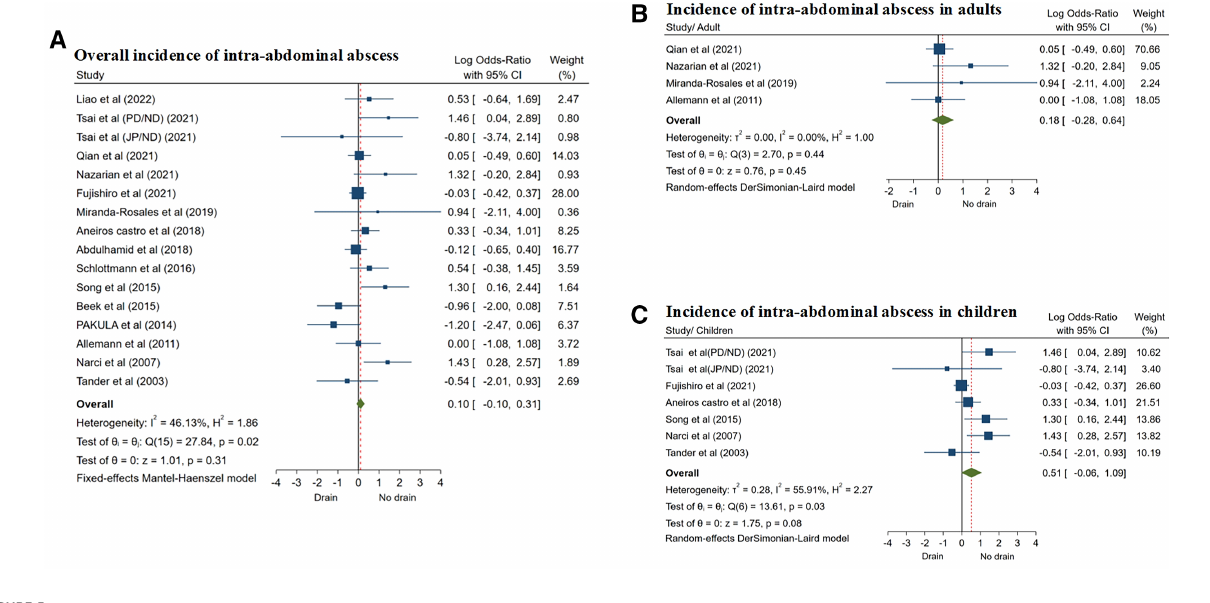
FIGURE 5 Forest plots of meta-analysis and subgroup meta-analysis comparing intra-abdominal abscess, ( A ) overall incidence of intra-abdominal abscess; ( B ) incidence of intra-abdominal abscess in adults; ( C ) incidence of intra-abdominal abscess in